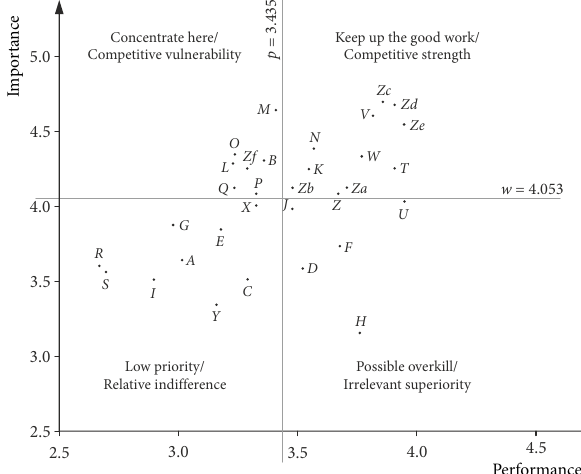
Figure 8. Standard IPA (source: adapted from Lee et al., 2020, p.